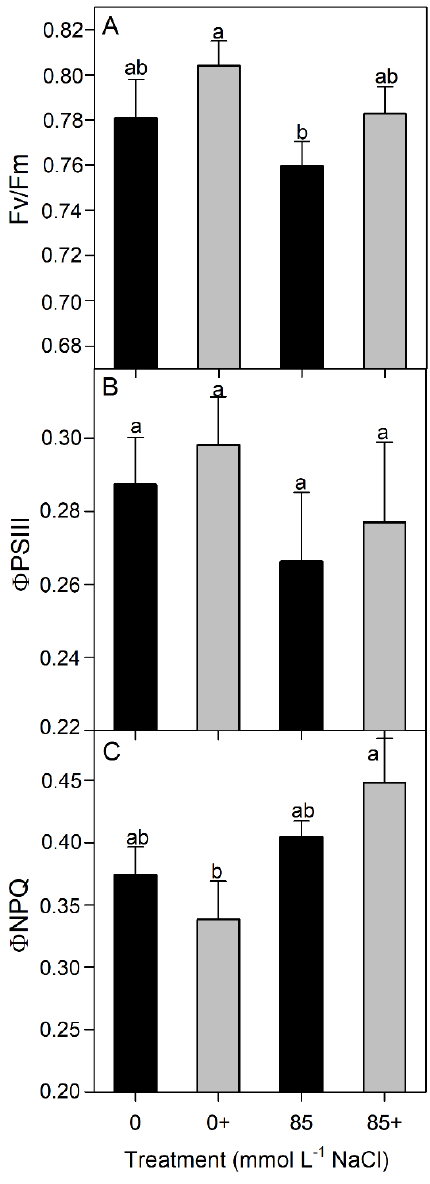
Figure 5. ( A ) Maximum quantum efficiency of PSII photochemistry (Fv/Fm), ( B ) quantum yield of PSII photochemistry ( Φ PSII) and ( C ) quantum yield of non-photochemical quenching ( Φ NPQ) of Swiss chard after 30 d of treatment with 0 and 85 mmol L − 1 NaCl, non-inoculated and inoculated (+). Each value represents the mean of nine replicates ±SE. Different letters indicate means that are significantly different from each other (ANOVA; Duncan test, p <0.05).